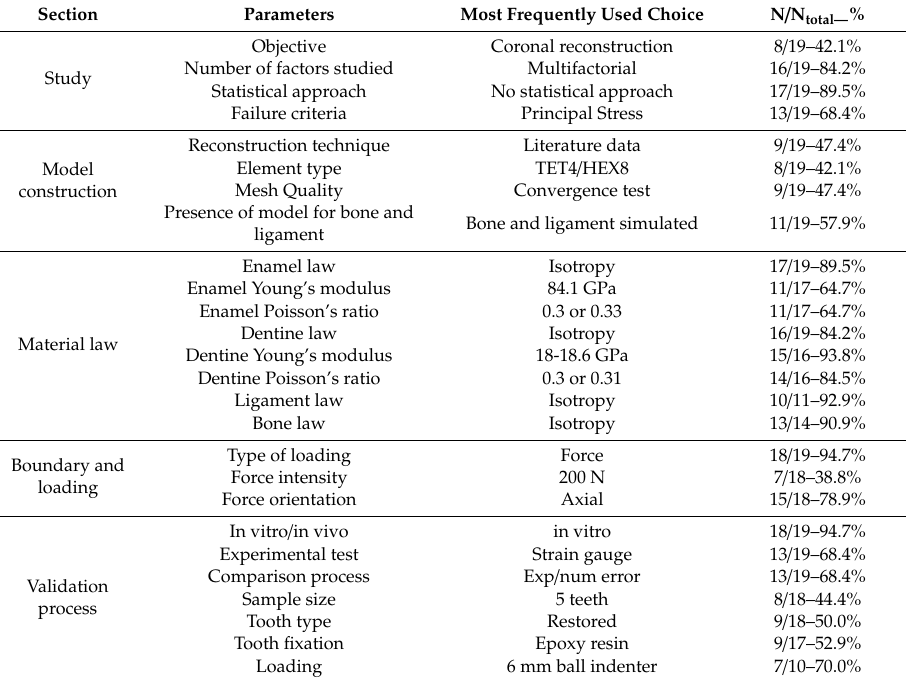
Table 3. Usage trends of parameters among validated